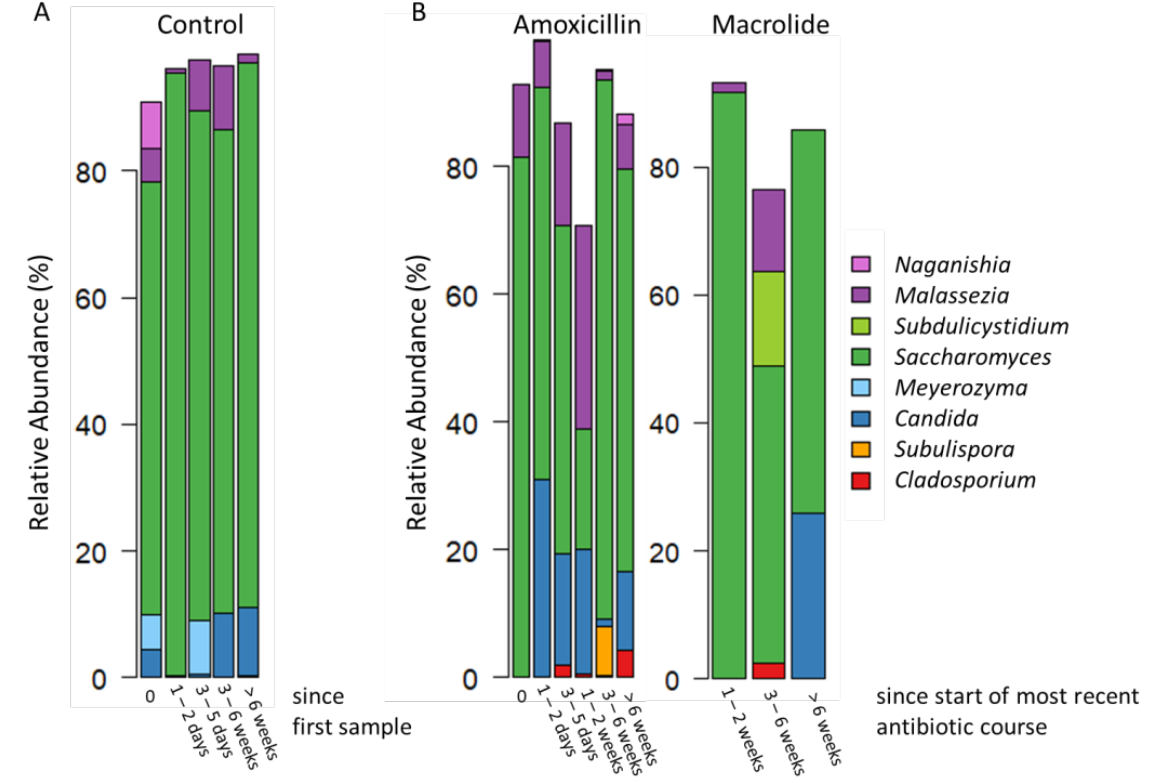
Figure 1. The gut fungal microbiota (mycobiota) composition presented as mean relative abundances of the most abundant fungal genera (presented on the right side of the figure) in ( A ) infants that were antibiotic-naïve throughout the follow-up and ( B ) infants that were antibiotic-naïve at baseline (marked as 0) but received amoxicillin or macrolide antibiotic treatment during follow-up. For the infants who received multiple antibiotics, the timepoints are calculated as time since the most recent antibiotic. All macrolide-treated patients received at least one course of amoxicillin prior to the macrolide course. Detailed results of the statistical differences between the antibiotic-treated and antibiotic-naïve groups are presented in Supplementary Tables S2 – S6.